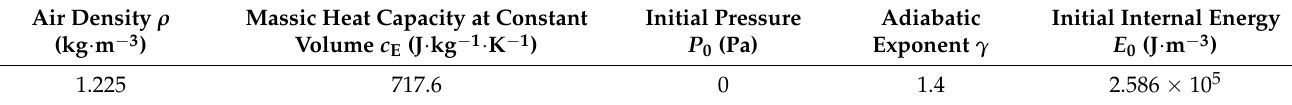
Table 4. Material parameters of air [26].